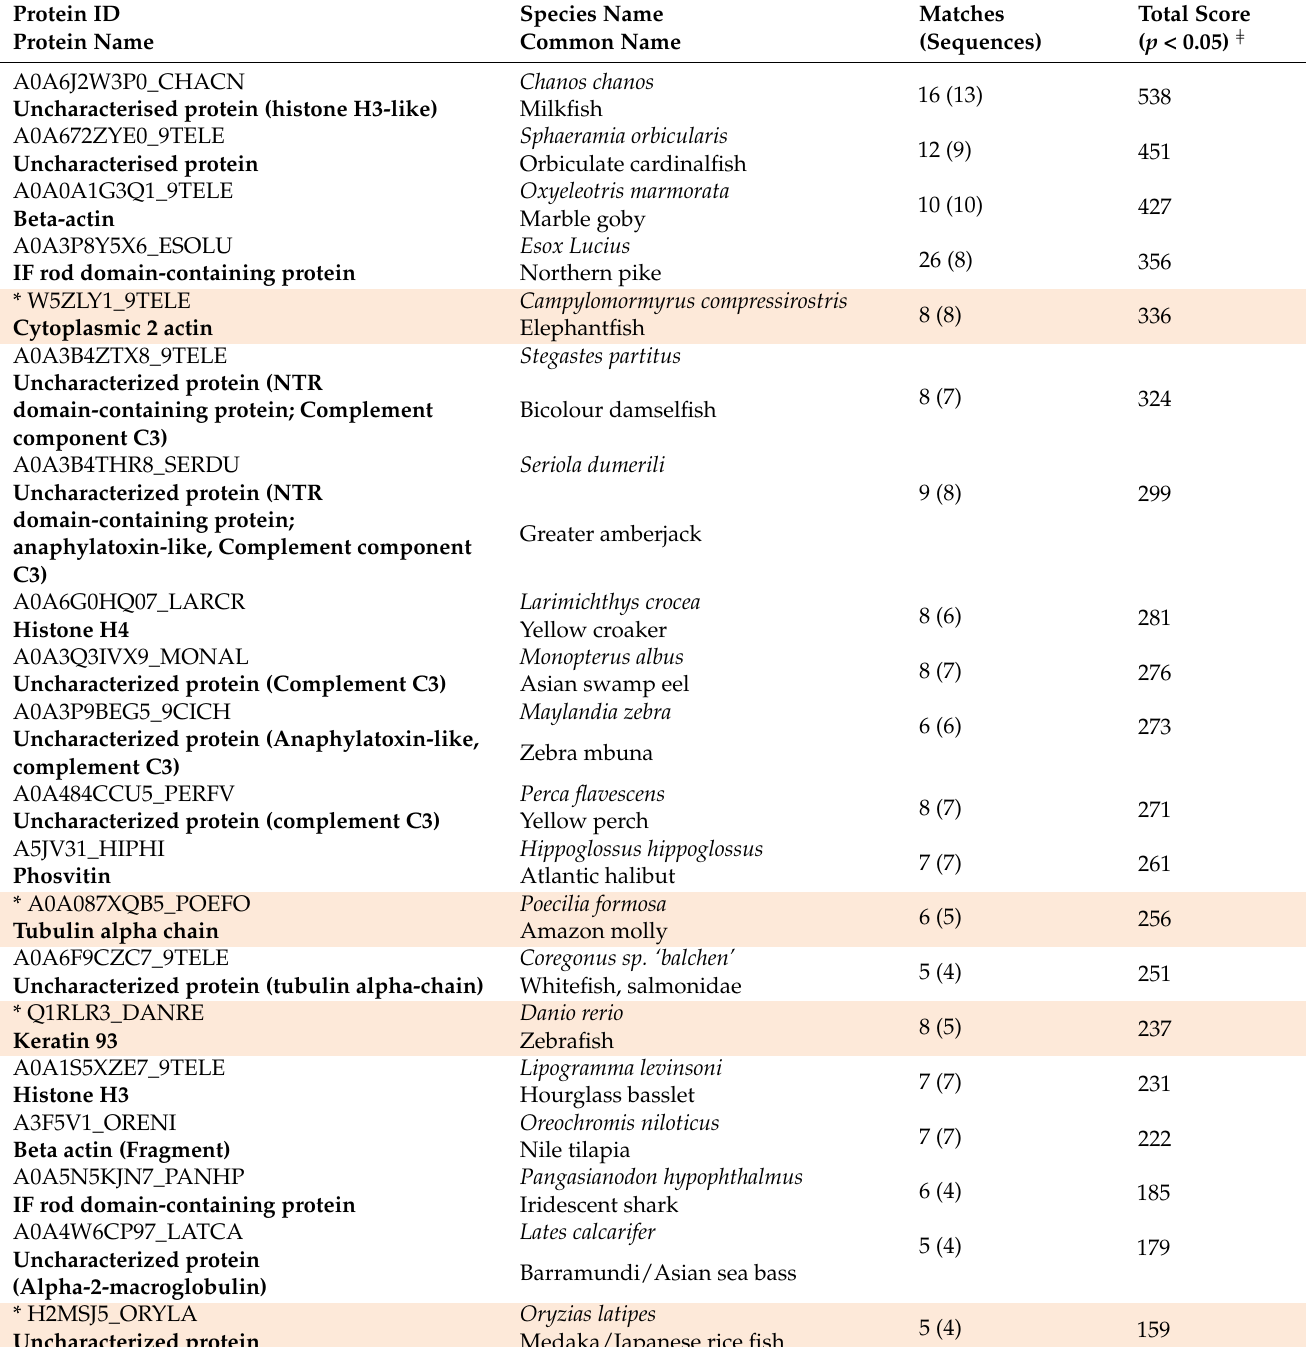
Table 1. Deiminated proteins in serum extracellular vesicles (EVs) of halibut ( Hippoglossus hippoglossus L), as identified by F95-enrichment in conjunction with LC-MS/MS analysis. Deiminated proteins were isolated from serum-EVs from a pool of n = 4 fish, using immunoprecipitation with the pan-deimination F95 antibody. The resulting F95-enriched eluate was then analysed by LC-MS/MS and peak list files submitted to Mascot, using the Teleost UniProt database. Peptide sequence hits are listed, showing the number of sequences for protein hits and total score. Species hit names are indicated. In the case of uncharacterised protein ID, proteins matching the same set of peptides are indicated in brackets. Protein hits highlighted in pink (*) are specific to the F95 enriched EV fraction only. Protein names are written in bold. A full list of protein sequence hits and peptides is further provided in Supplementary Table